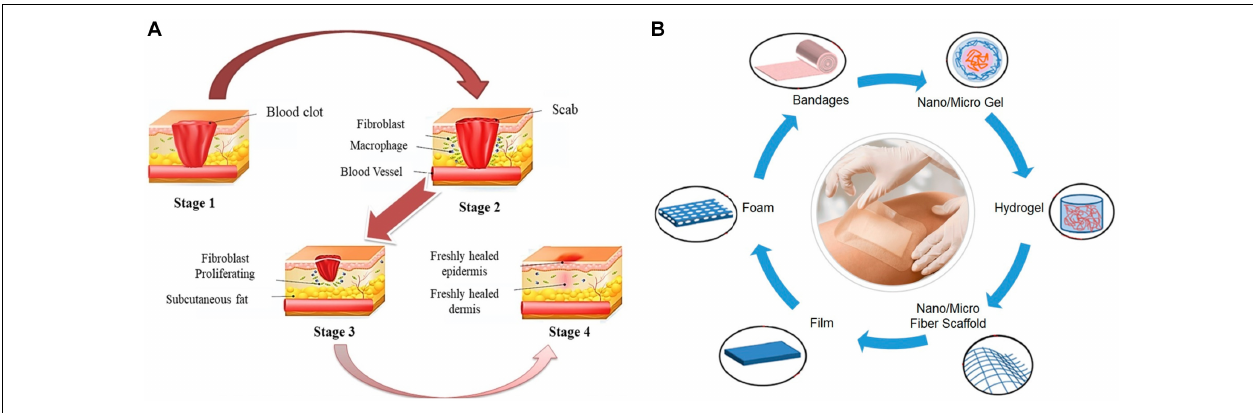
FIGURE 1 | (A) Wound self-healing process (Moeini et al., 2020). (B) Different forms of wound dressings (Teixeira et al.,